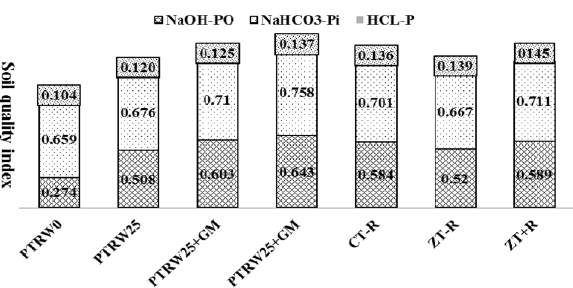
Figure 8. Average effect of rice and wheat treatments on soil quality index and the individual contribution of each of the key indicators. PTR W0 -puddled transplanted rice with no wheat straw, PTR W25 -puddled transplanted rice with 25% anchored wheat straw retained, GM-Green manure, CTW R0 -conventional tillage wheat with rice straw removed, ZTW